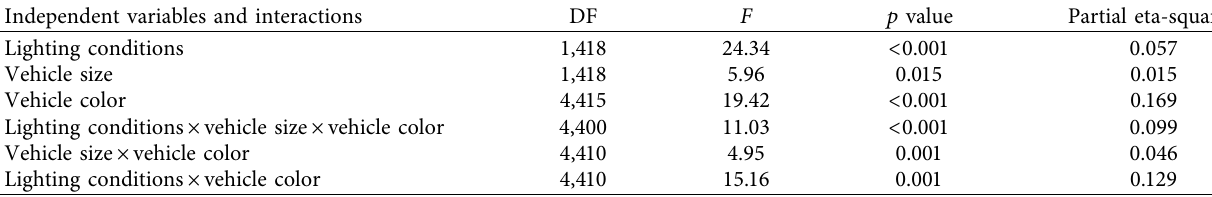
Table 2: Main and interaction effects for front identification distance.